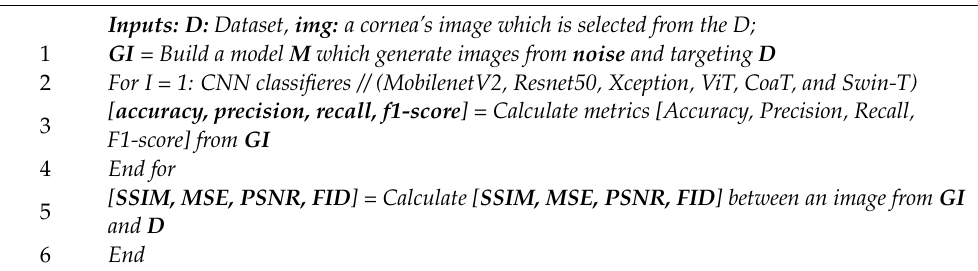
Algorithm 1. Algorithm of the Proposed Method.